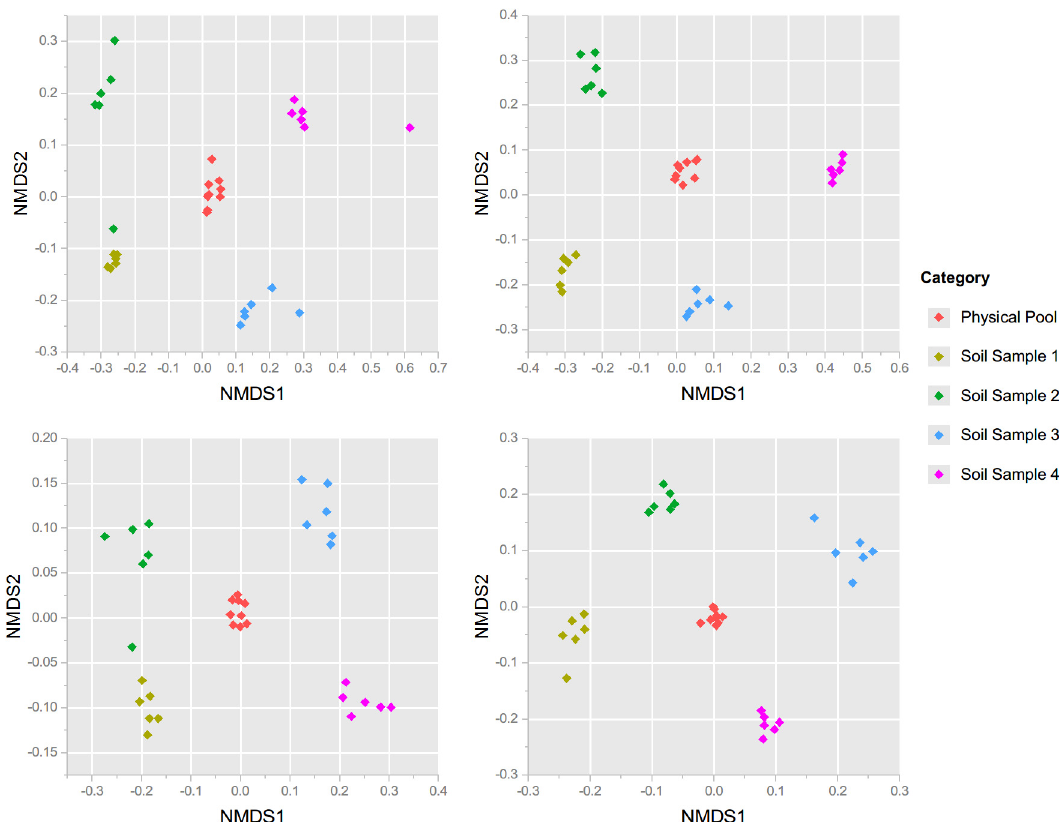
Fig 4. Nonmetric Multidimensional Scaling Plot of physical pools and individual plot samples from each site. Plots based on either Bray-Curtis distance matrices generated from rarefied taxon abundances of A. CCR and B. CFC or from presence/absence matrix of C. CCR and D. CFC.